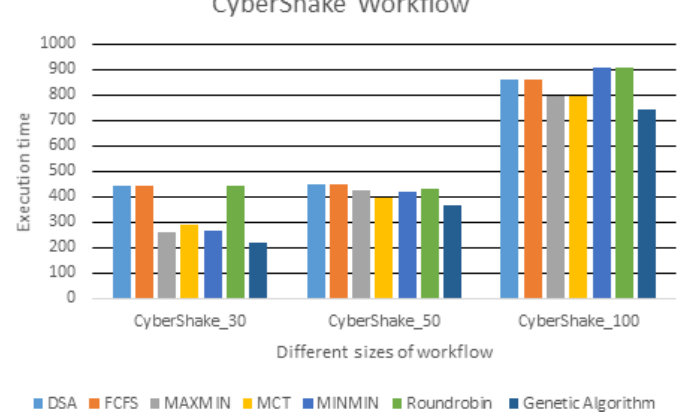
Fig. 7. Execution time required for cyber-shake using di®erent